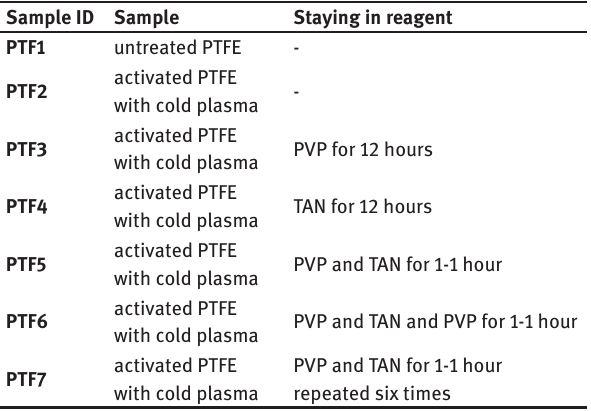
Figure 1 : Optical emission spectra recorded over the plasma surface. Table 1 : The different samples prepared by treating the polytetra- fluoroethylene (PTFE) and coating it with organic (PVP – polyvinylpyrrolidone, TAN – tannic acid) single- and